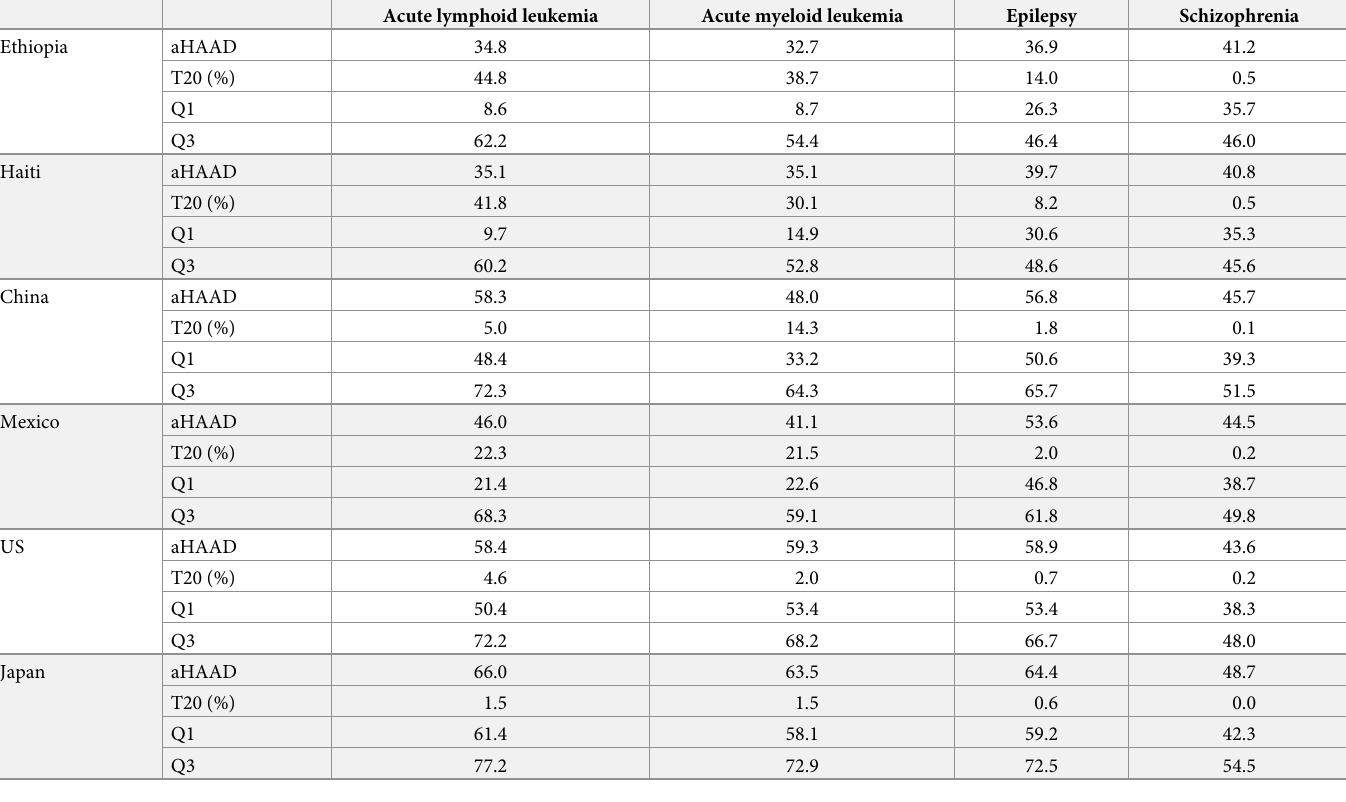
Table 2. Average Health Adjusted Age at Death (aHAAD), T20, Q1 and Q3 for four conditions in six countries, results from 200 NCDI conditions can be found in the Appendix Table A4 (the GBD 2017 study [20] is source for all